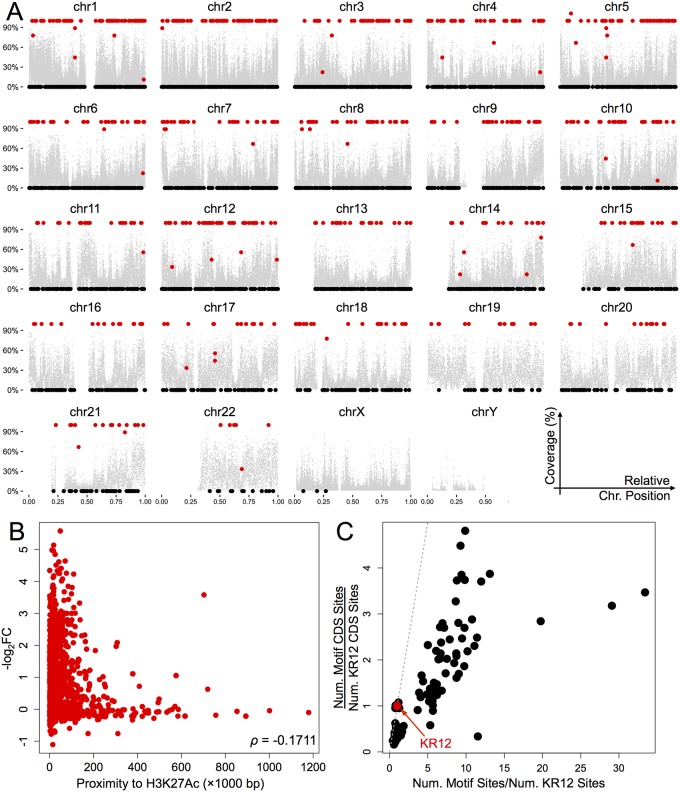
Chromatin accessibility of KR12.(A) Position-coverage plot of KR12 binding (9 bp per point, black and red) in relation to DHS regions (10,000 bp per point, gray) per chromosome. Horizontal axes, relative position along chromosome; vertical axes, relative coverage of a feature; for DHS regions, a coverage of 100% indicates that all 10,000 bp of a genomic region have DHS, while for KR12 sites, black spots (0%) indicate that a particular site is outside the boundaries of a DHS region, in contrast to the red sites (> 0%). (B) Gene expressions (vertical,–log2FC) as a function of KR12 site proximity (horizontal, 1000 bp) to the histone modification feature H3K27Ac. Spearman’s correlation coefficient (ρ = –0.171) suggests a weak correlation with histone modification. (C) Comparison of predicted binding site counts in coding regions (CDS) and in the hg19 genome for KR12 (red) against 100 randomly selected motifs (black, see S4 Table); horizontal axis, ratio of binding sites per motif/KR12 binding sites; vertical axis, ratio of binding sites in CDS per motif/KR12. Dashed line with slope of 1 (gray) is provided as reference.